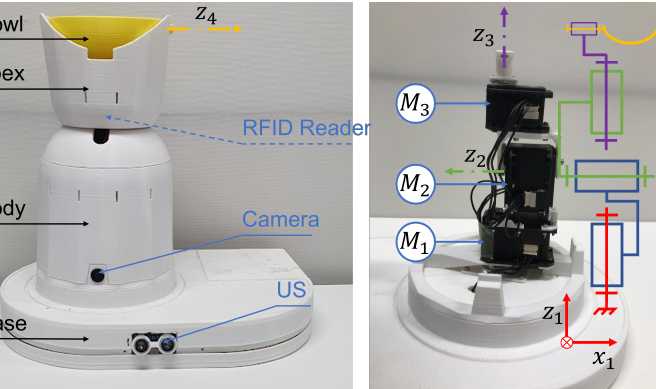
Figure 1. Parts and kinematic diagram of Y¯okobo. Dimensions of the robot in centimeters: H = 33; L = 36; W = 24; ø =